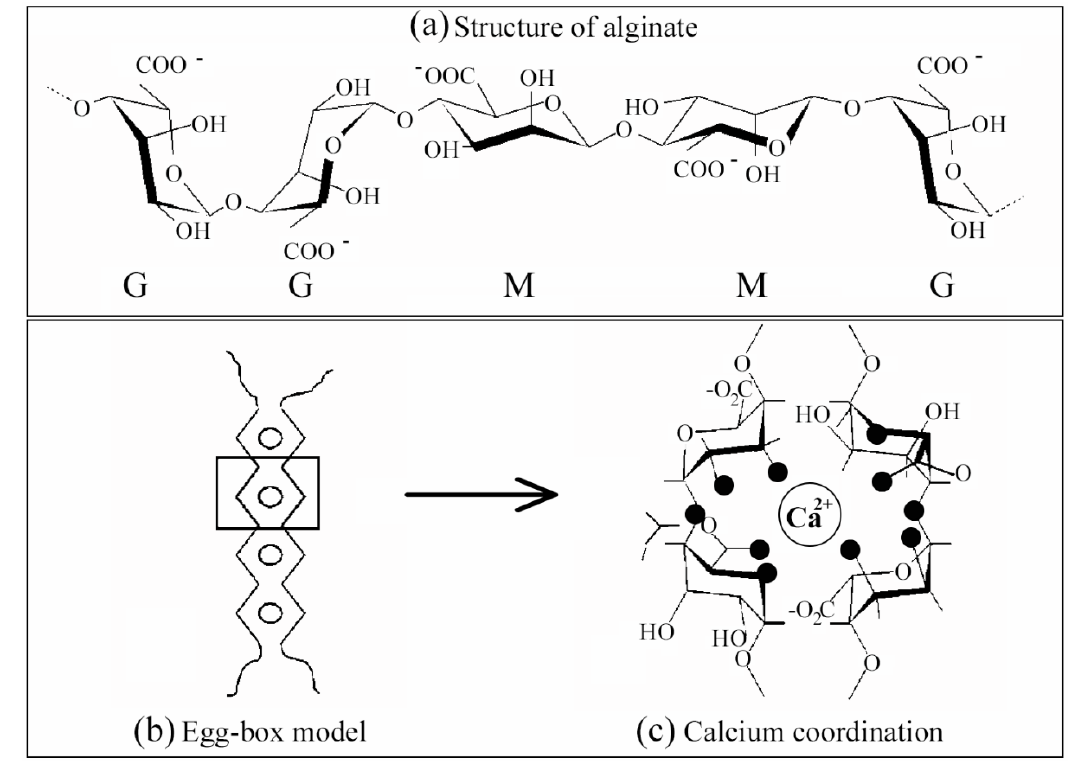
Figure 1. Chemical structure of alginate and alginate gelling: ( a ) β -(1 → 4)-D-mannuronic acid (M) and α -(1 → 4)-L-guluronic acid (G) blocks; ( b ) egg-box model; ( c ) calcium coordination described by the pair of guluronate chains in calcium alginate junction zones. Dark circles represent the oxygen atoms involved in the coordination of the calcium ion. Adapted with permission from reference [93].